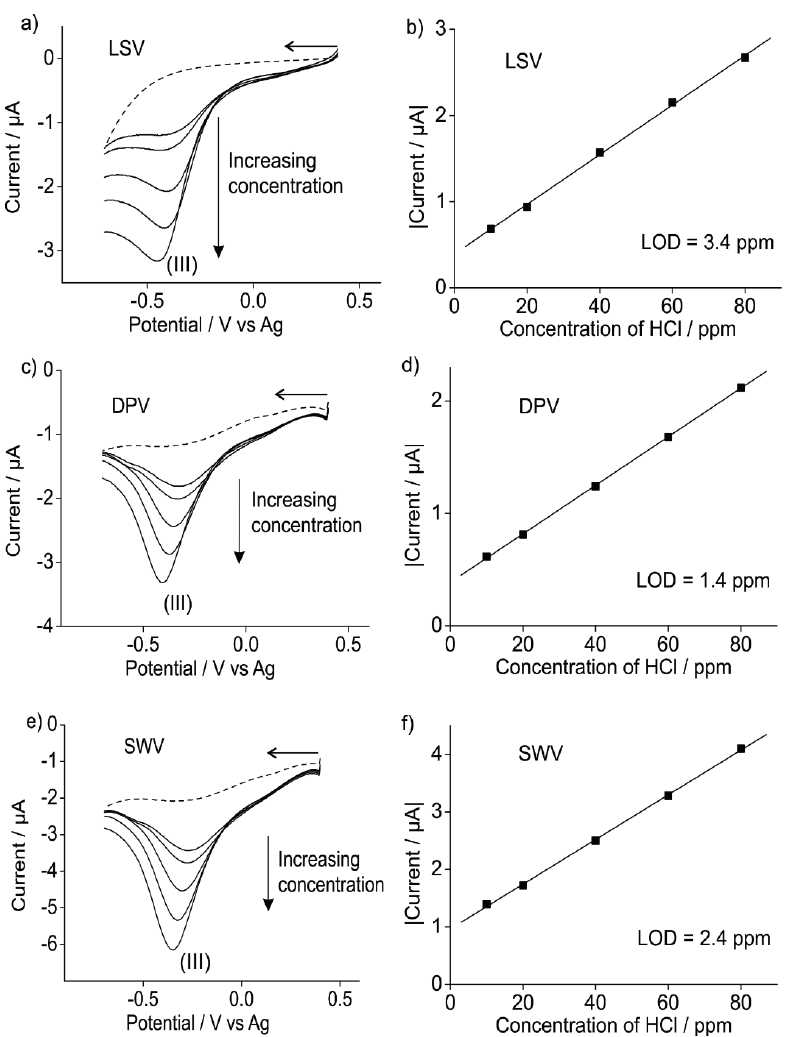
Figure 6. ( a ) LSV, ( c ) DPV and ( e ) SWV for the proton reduction peak at different concentrations of HCl (10, 20, 40, 60 and 80 ppm in the gas phase) on a Pt SPE in [C 2 mim][NTf 2 ]. Dashed line is the response in the absence of hydrogen chloride gas. The corresponding calibration plots obtained for ( b ) LSV, ( d ) DPV and ( f ) SWV using the peak currents from ( a , c , e ) are also